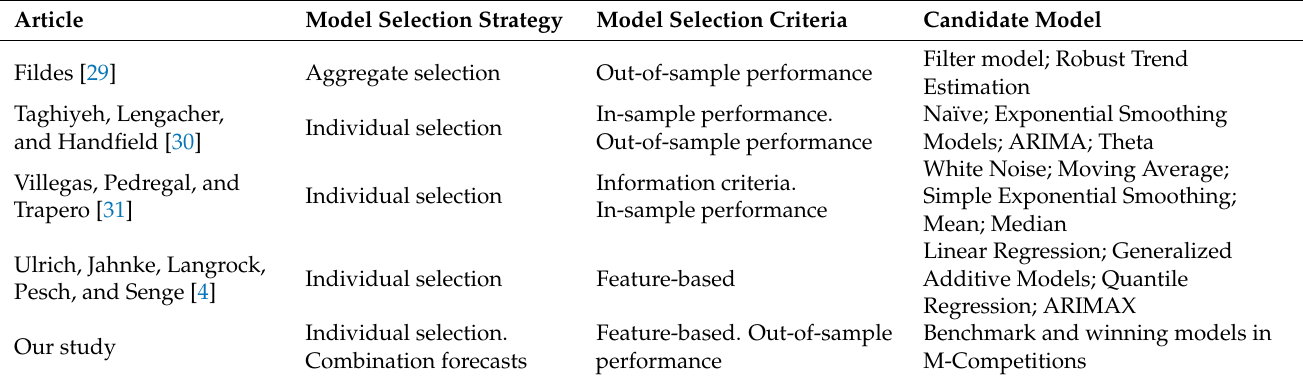
Table 1. Review of published literature for forecasting model